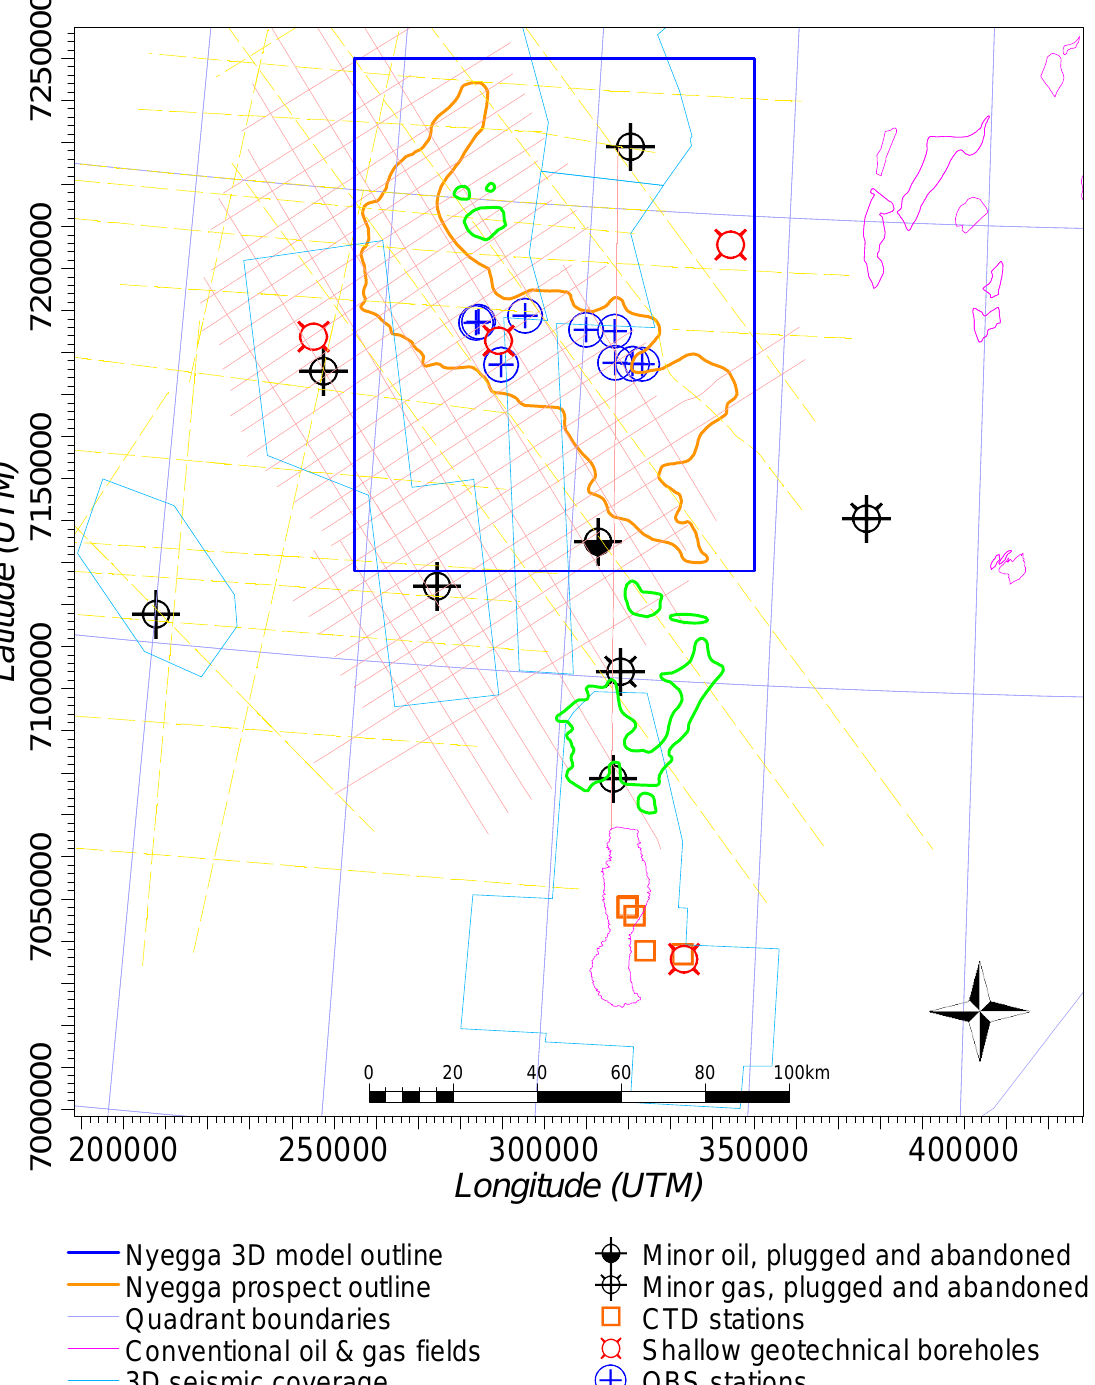
Figure 4. Location map showing the data, including seismic, borehole and oceanographic data, used to generate the 3D model. Please note that the stippled yellow lines indicate 2D seismic data used to tie the key 2D seismic data set, JMF97 (pink solid lines), to the wells. Also note that the study area only contains the largest BSR extent, while other prospects where BSRs are identified provide an upside